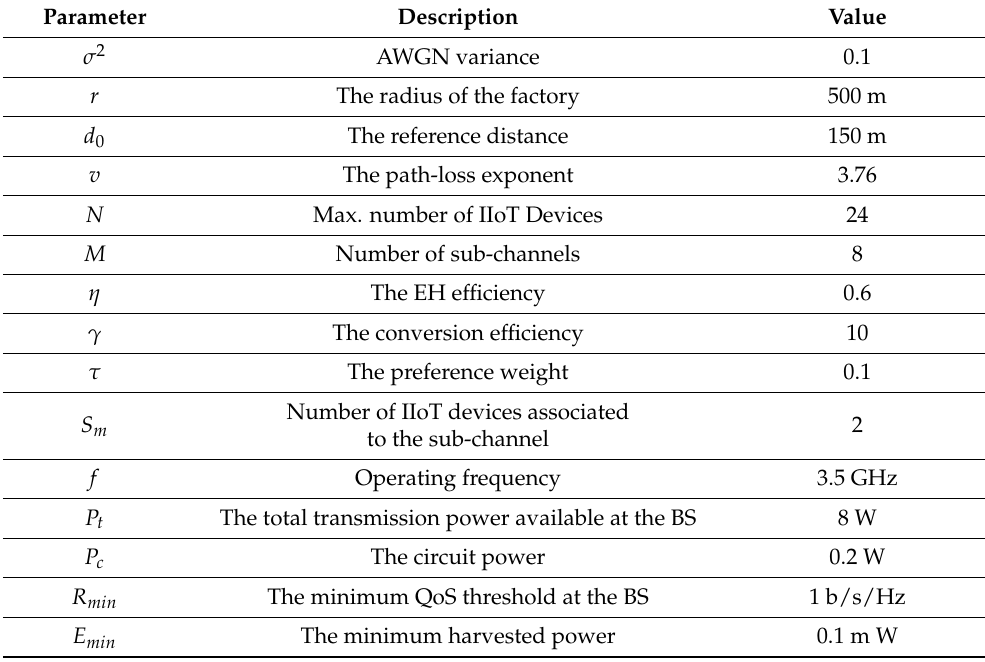
Table 2. Simulation